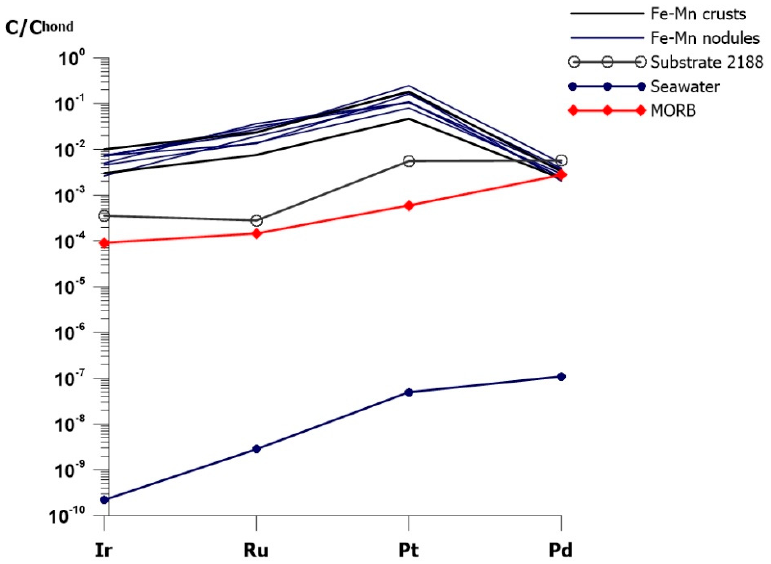
Figure 9. CI chondrite-normalized [47] PGE patterns in studied nodules, crust, and substrate. For comparison, the MORB [46] and seawater [43] PGE patterns are shown.